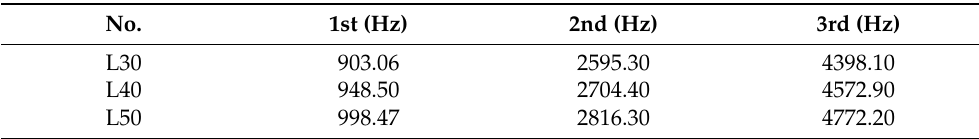
Figure 3. Measured FRF at sensor location A 2 of the threadless specimen (source elaborated by authors). Table 2. First three order frequencies of the threadless specimen from the FEM (source elaborated by authors).